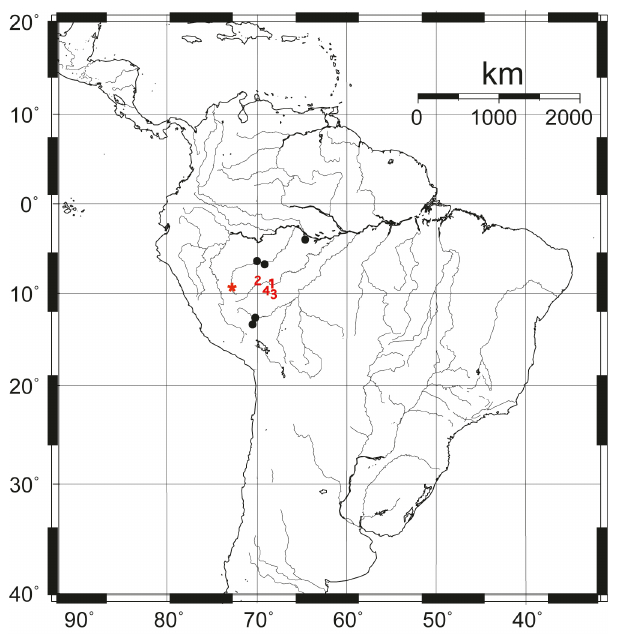
Figure 1. Leptodactylus didymus Geographic distribution of in South America. Black dots are literature records, red star is the type locality and red numbers are the new records: 1) Boca do Acre, Amazons; 2) Feijó, Acre; 3) Senador Guiomar, Acre; 4) Rio Branco,